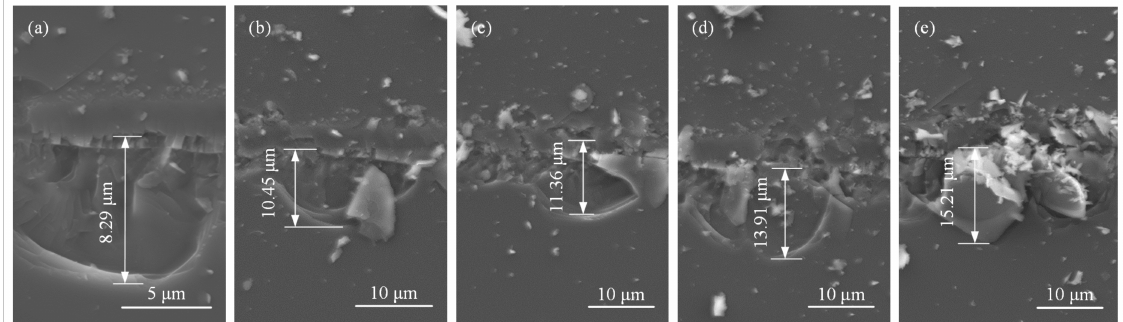
Figure 13. Edge damage size generated relatively large peeling as measured by SEM: ( a ) FN = 0.172 N,